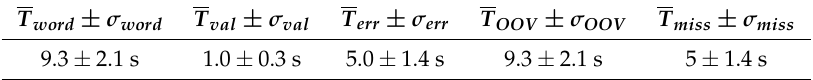
Table 2. Means and standard deviations of the times measured during the word